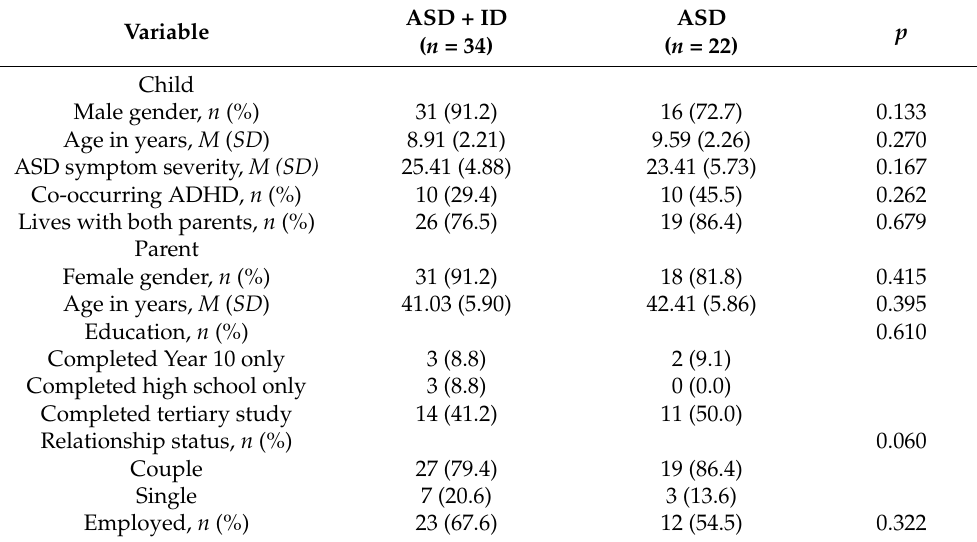
Table 1. Sample Characteristics of Parents and Children with ASD and ASD +